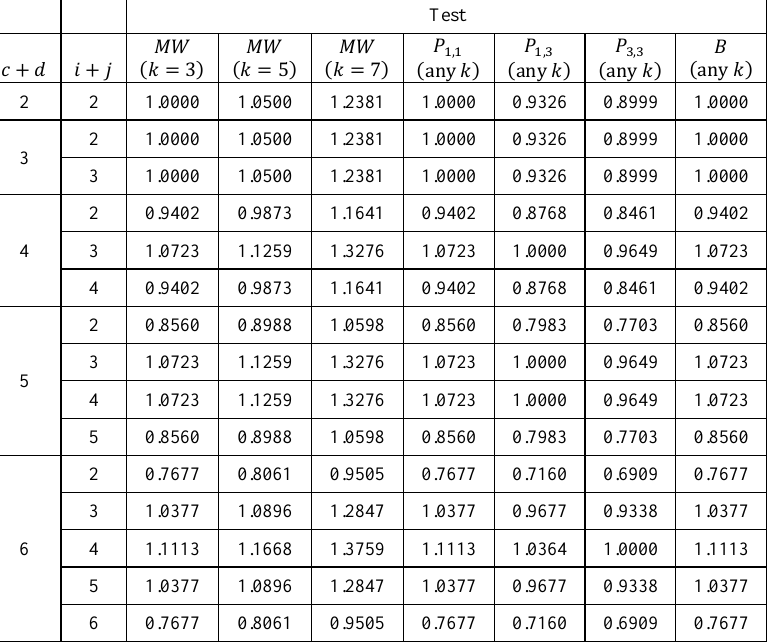
Table 5. AREs of 𝑇 for Laplace distribution w.r.t. different 𝑐,𝑑;𝑖,𝑗